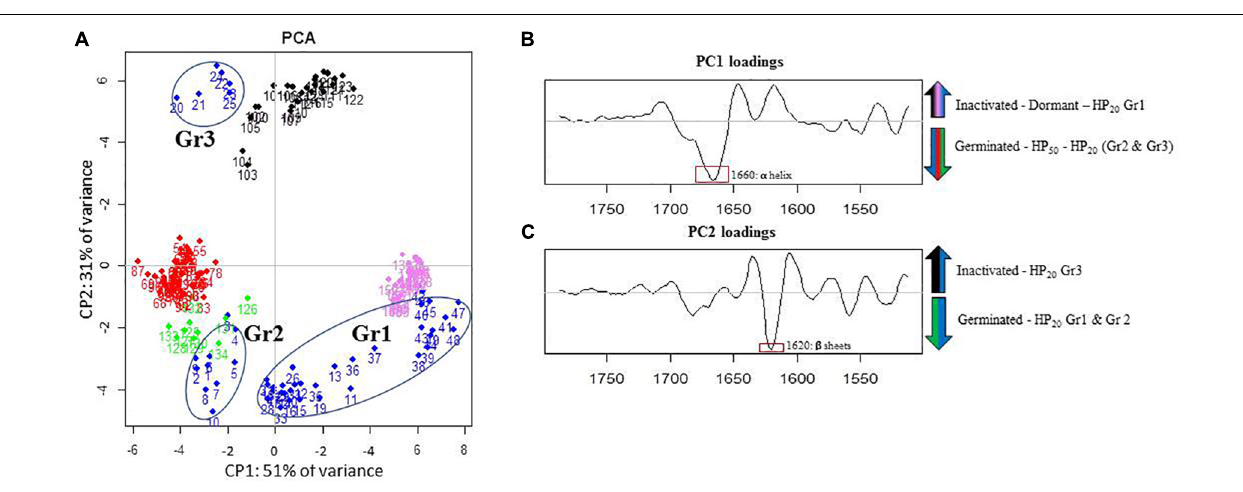
FIGURE 6 | Principal component analysis (PCA) of infrared spectra obtained on control spore samples (germinated: green dots; dead: black dots; dormant: pink dots) and spores treated by high pressure (HP) at 500 MPa for 10 min at 50 ◦ C (red dots) or 20 ◦ C (blue dots) in the amide I and II spectral